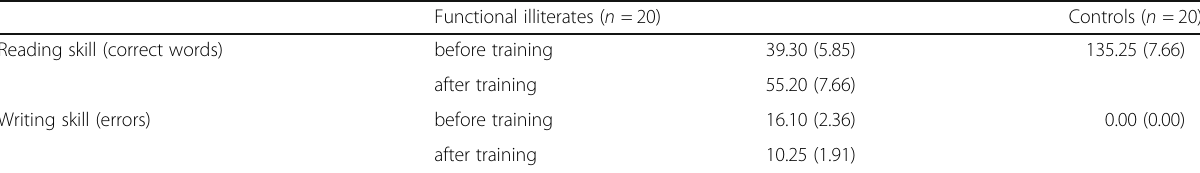
Table 1 Literacy skills of functional illiterates and controls (mean and SD) Functional illiterates ( n = 20) Controls ( n = 20) Reading skill (correct